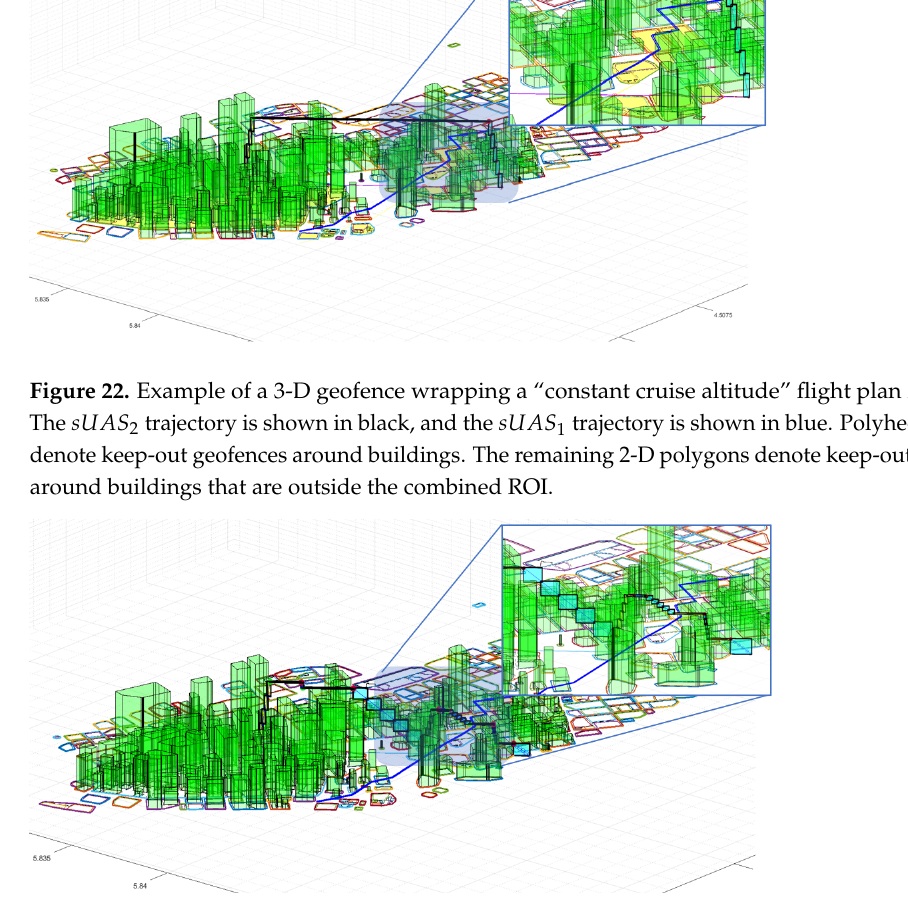
Figure 23. Example of a 3-D geofence wrapping a “terrain follower” flight plan for sUAS 2 . The sUAS 2 trajectory is shown in black, and the sUAS 1 trajectory is shown in blue. Polyhedra (green) denote keep-out geofences around buildings. The remaining 2-D polygons denote keep-out geofences around buildings that are outside the combined